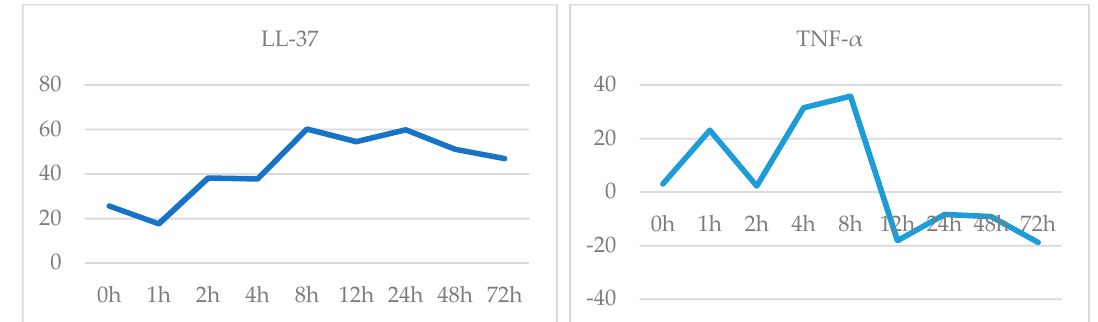
Figure 2. Cell Viability-time chart of high-dose LPS.